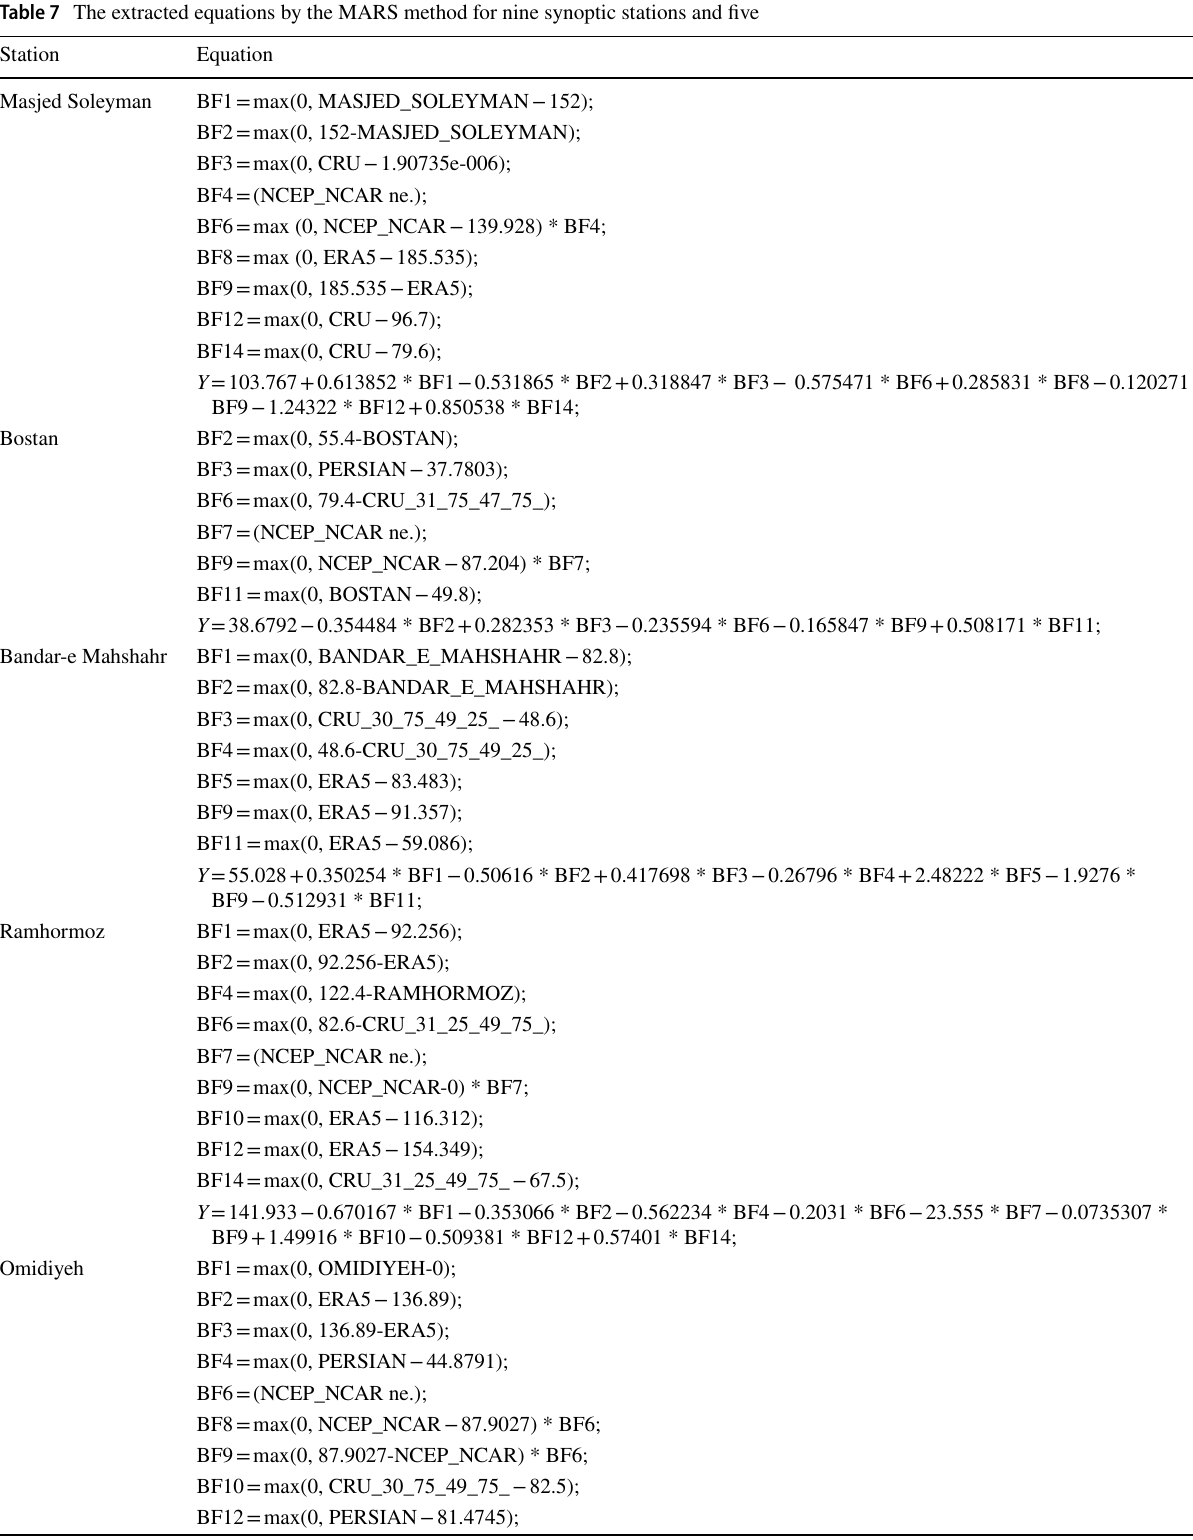
Table 7 The extracted equations by the MARS method for nine synoptic stations and five